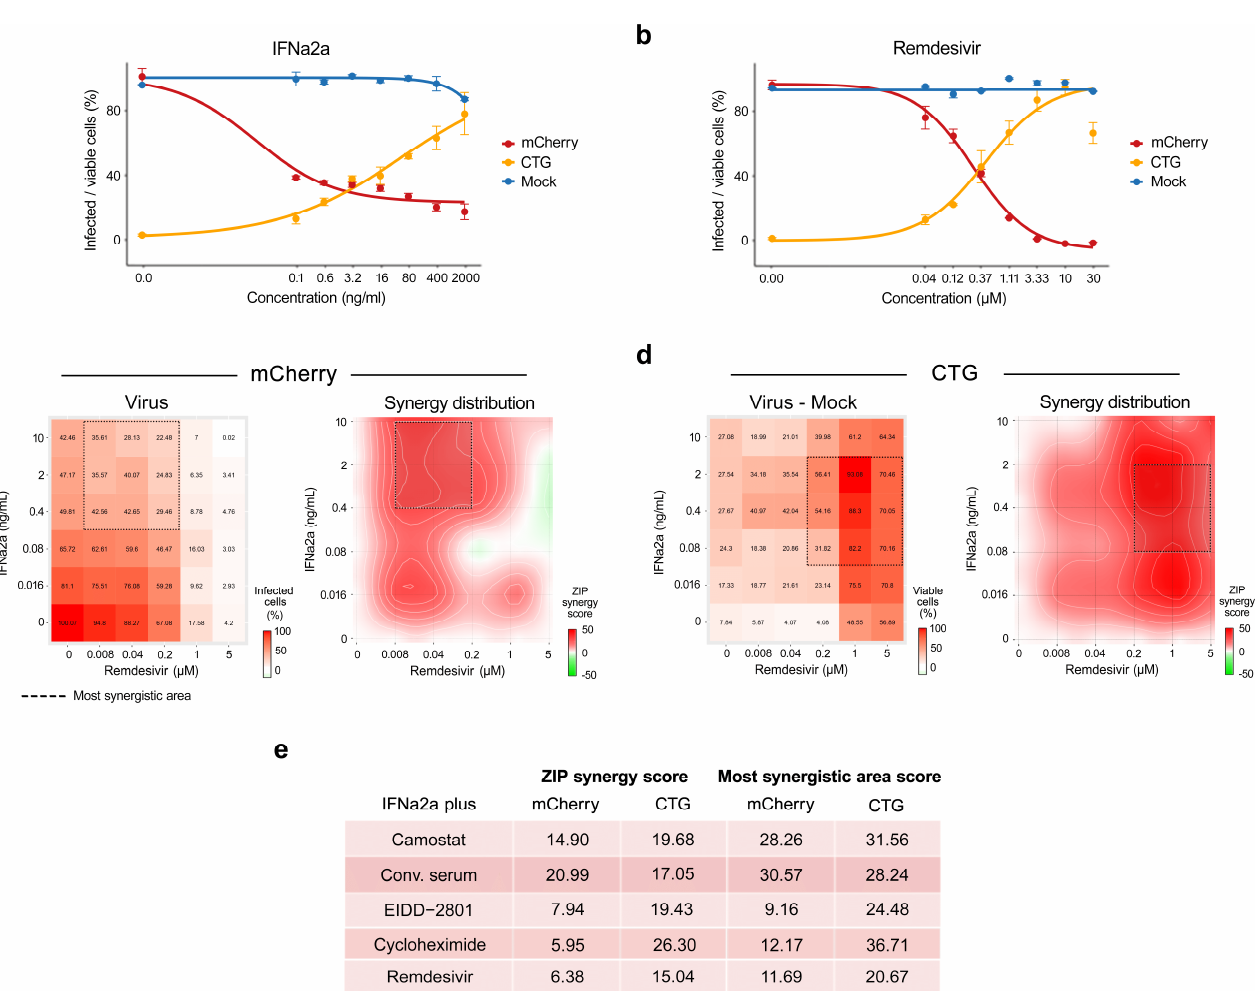
Figure 5. Synergistic IFNα2a-based combinations against SARS-CoV-2-mCherry infection in Calu-3 cells. ( a , b ) Calu-3 cells were treated with increasing concentrations of IFNα2a or remdesivir, and infected with the SARS-CoV-2-mCherry or mock. After 48 h, the virus-mediated mCherry expression was measured (red curves). After 72 h, viability of virus- and mock-infected cells was determined using a CTG assay (yellow and blue curves, respectively). Mean ± SD; n = 3. ( c ) The 6 × 6 dose–response matrices and interaction landscapes of IFNα2a and remdesivir obtained using fluorescence analysis of SARS-CoV-2-mCherry-infected Calu-3 cells. ZIP synergy score was calculated for the drug combinations. ( d ) The 6 × 6 dose–response matrices and interaction landscapes of IFNα2a and remdesivir obtained using a cell viability assay (CTG) on mock- and SARS-CoV-2-mCherry-infected Calu-3 cells. The selectivity for the indicated drug concentrations was calculated (selectivity = efficacy-(100-Toxicity)). ZIP synergy scores were calculated for indicated drug combinations. ( e ) ZIP synergy scores (synergy score for whole 6 × 6 dose–response matrix) and the most synergistic area scores (synergy score for most synergistic 3 × 3 dose-regions) calculated for indicated drug